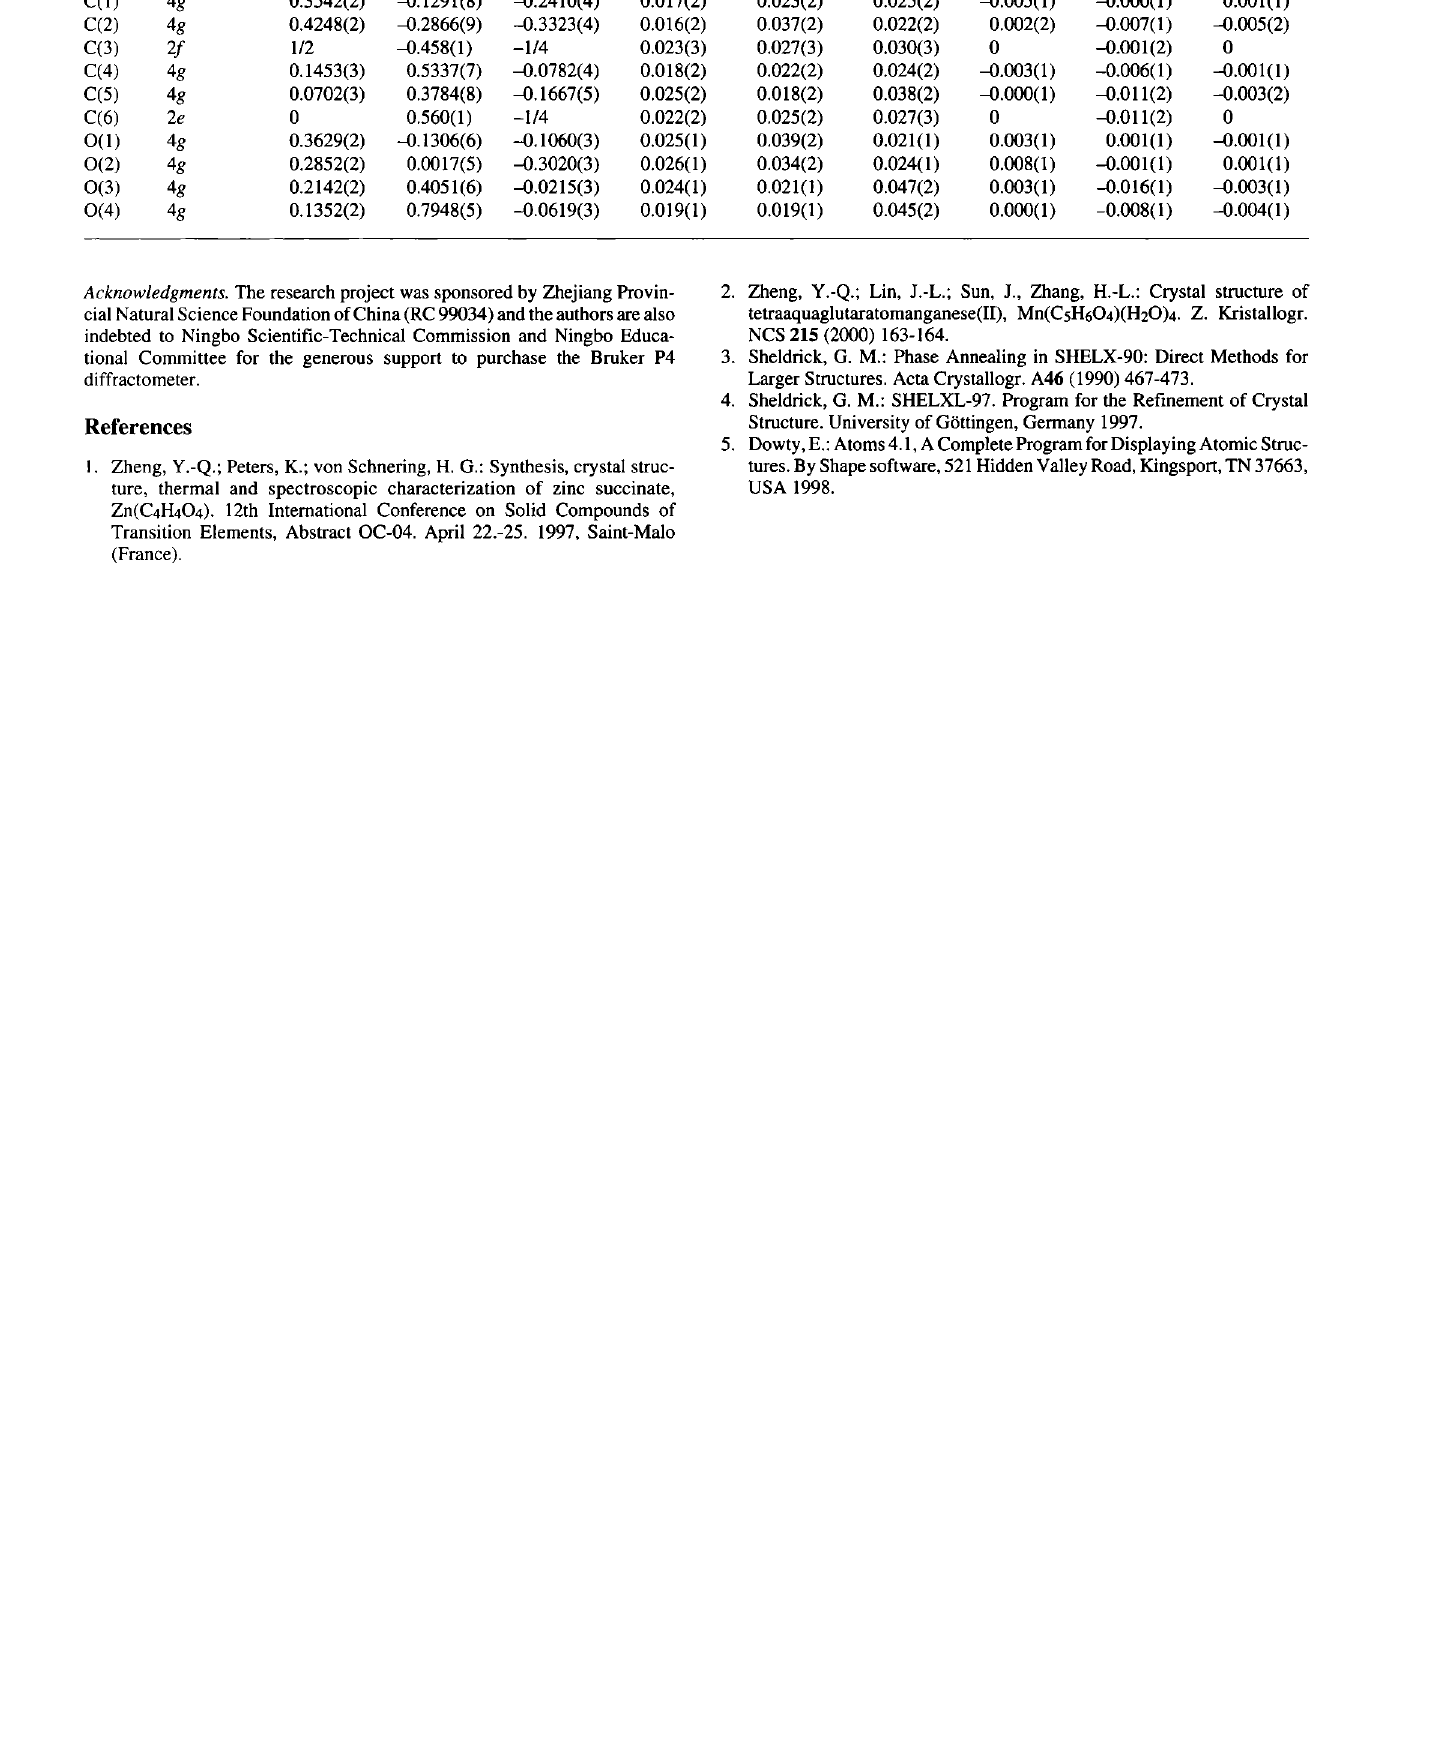
Table 3. Atomic coordinates and displacement parameters (in Ä 2